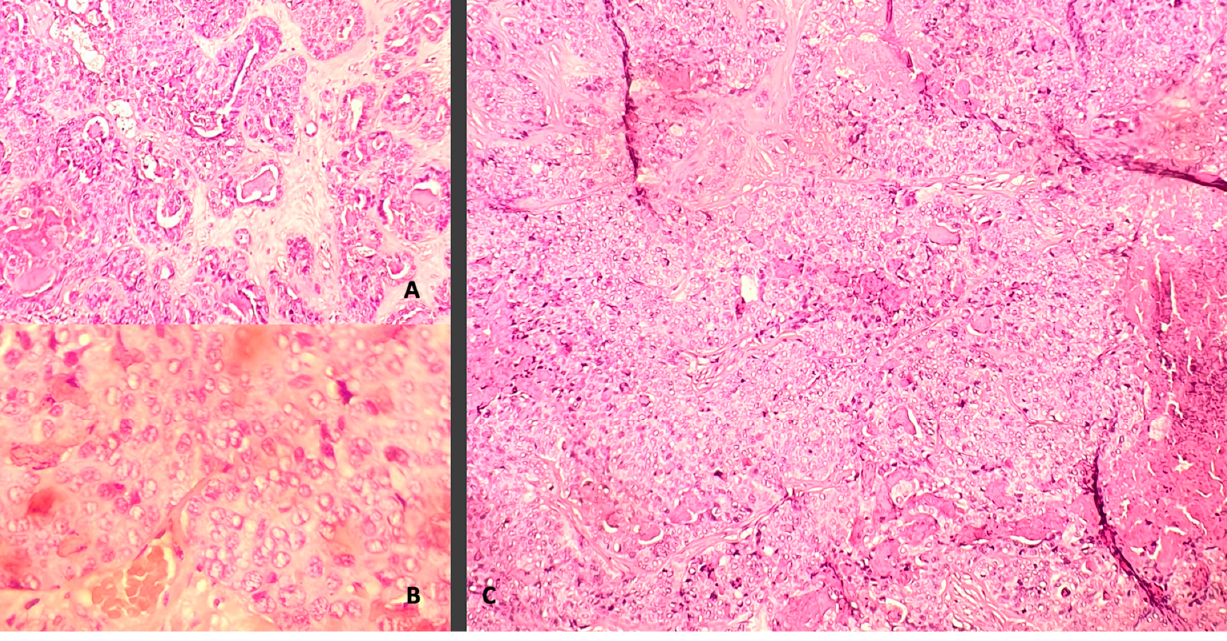
Figure 3. Adenocarcinoma with glandular differentiation ( A ) and with solid and necrotic areas ( B ). At higher magnification, ( C ) note pleomorphic nuclei, eosinophilic nucleoli and mitotic figures.